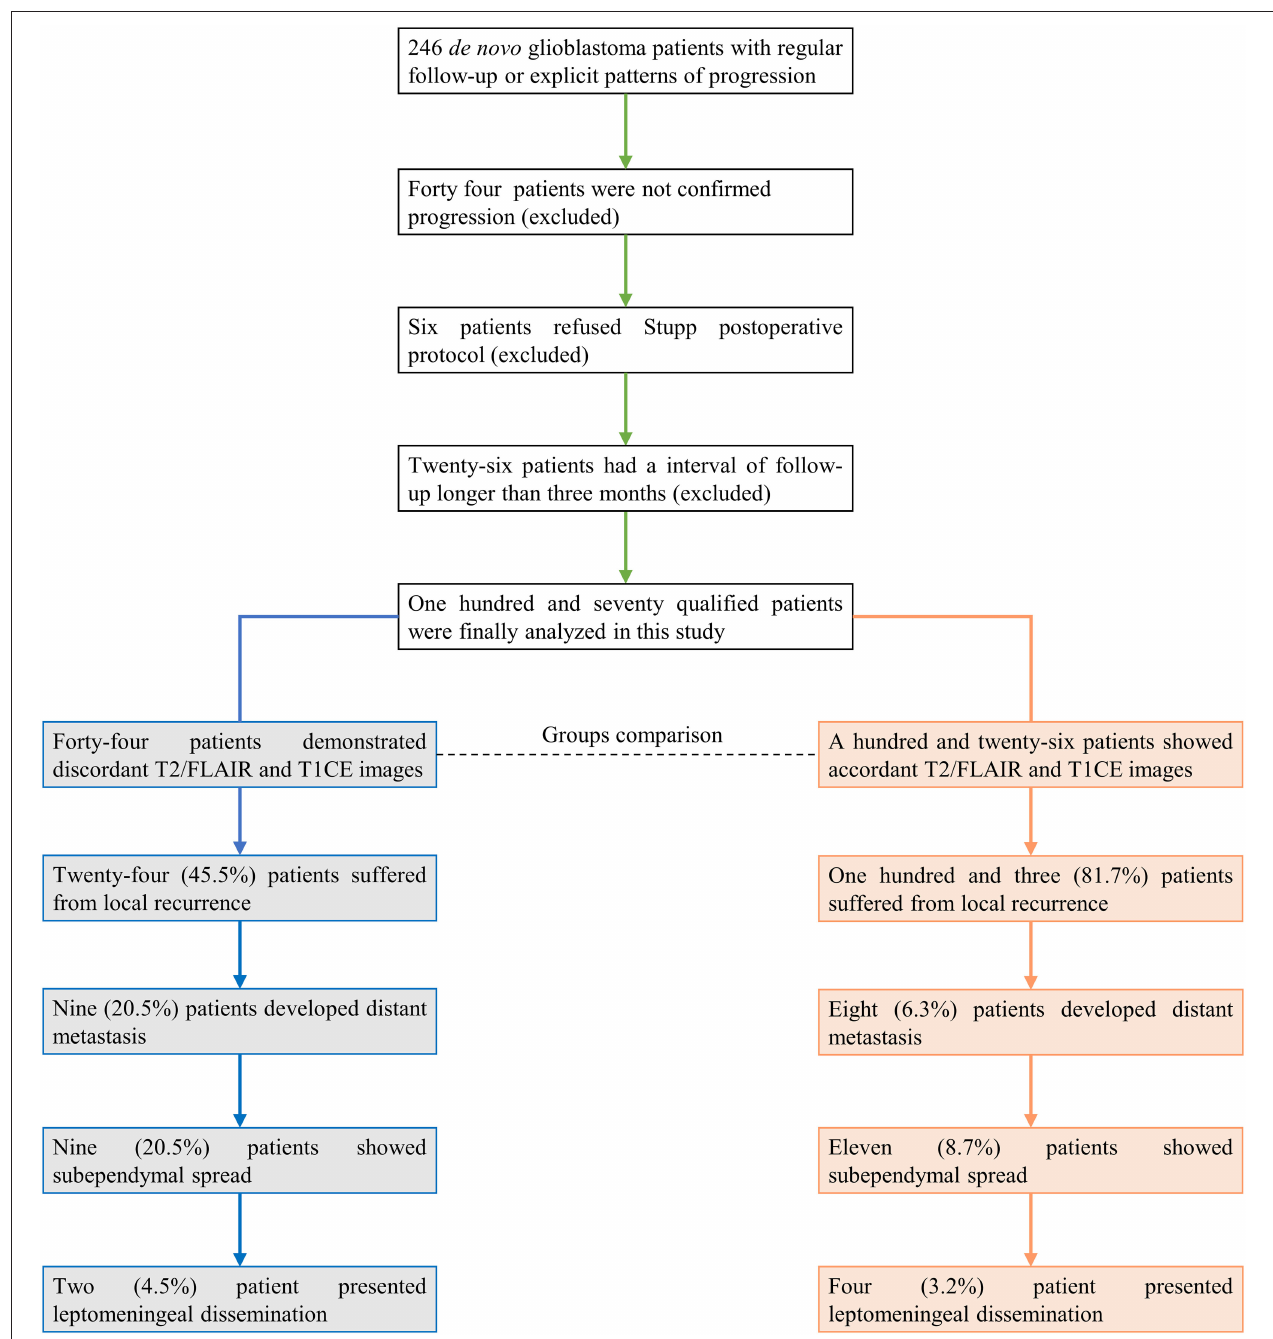
FIGURE 1 | Patients included in this study. The final analysis showed that 25.9% of patients (44/170) presented discordant results between T2/FLAIR and T1CE